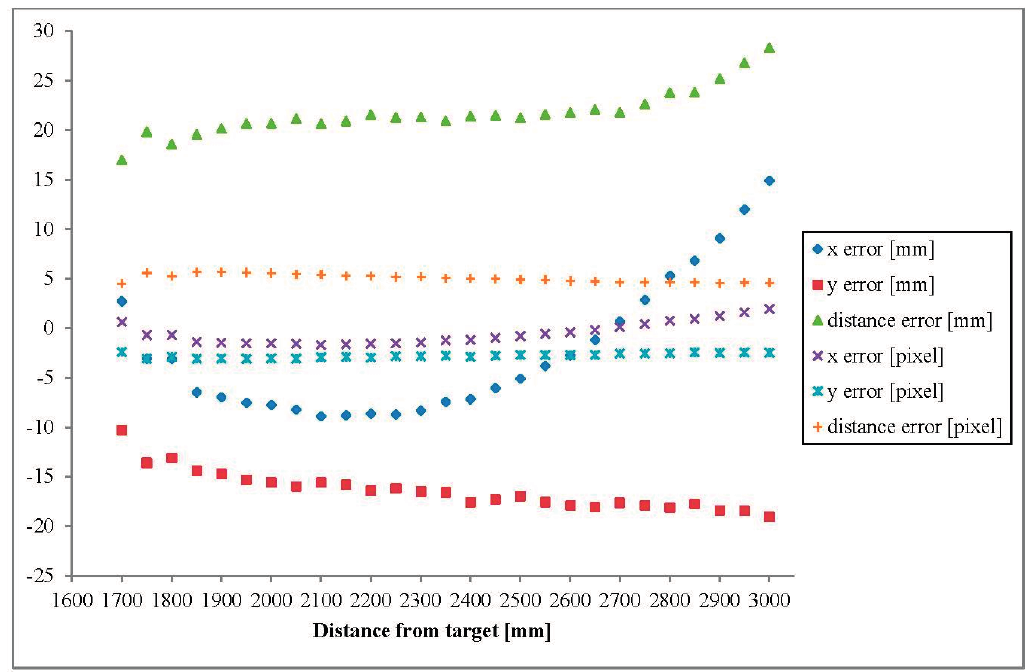
Figure 10. Registration errors while applaying